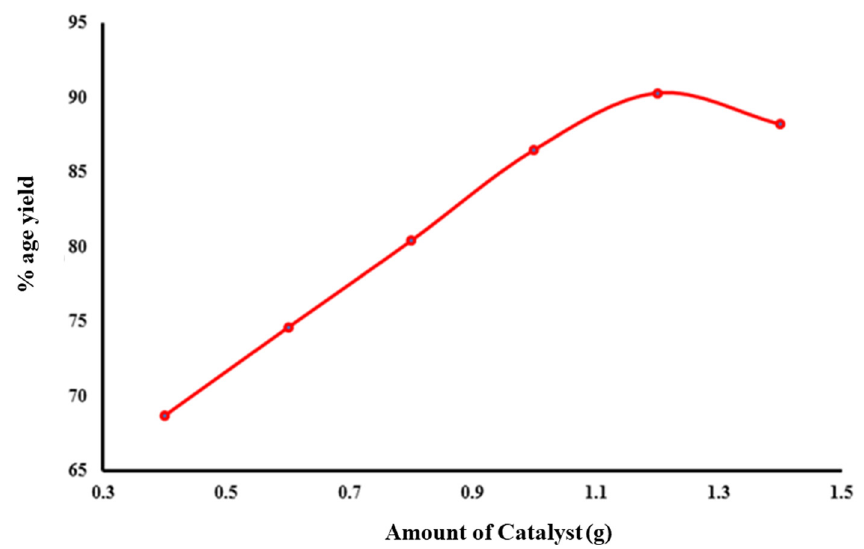
Figure 3. Graph showing the effect of the catalyst dose in grams on the percentage yield of biodiesel. Table 2. Various factors, such as the amount of catalyst, methanol ration, and temperature, affecting the yield of